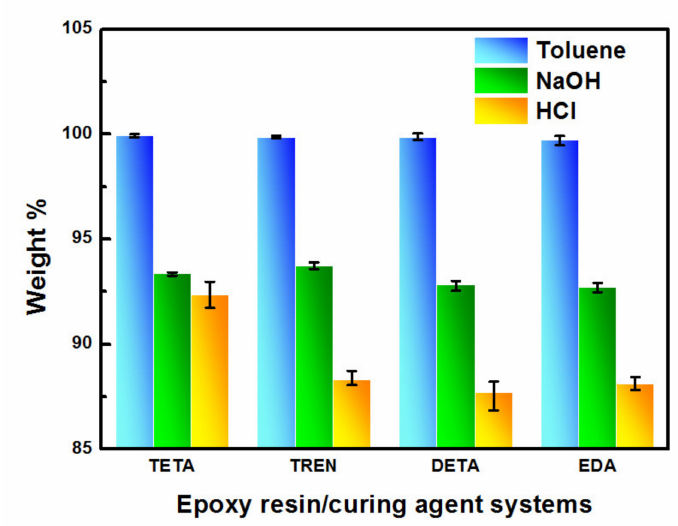
Figure 5. Gel content and acidic and alkaline resistance of the cured bioepoxies with various curing agents.